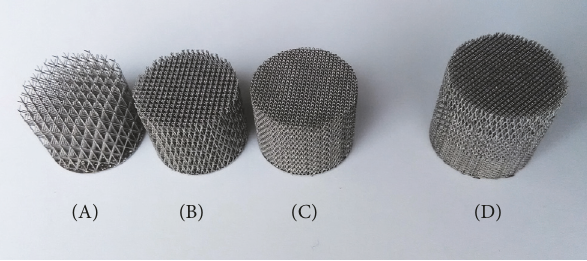
Figure 1: (A) Low, (B) average, (C) high volume fraction lattice structures, and (D) functionally graded lattice (FGL) structure used in the current research for samples No. 5 and No. 6 exclusively (diameter of lattice structures are 20